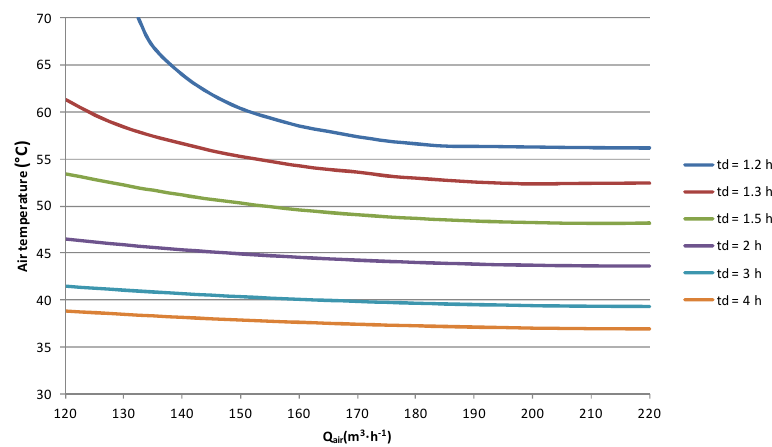
Figure 5. Isocontours of drying time (air temperature vs. flow rate diagram).